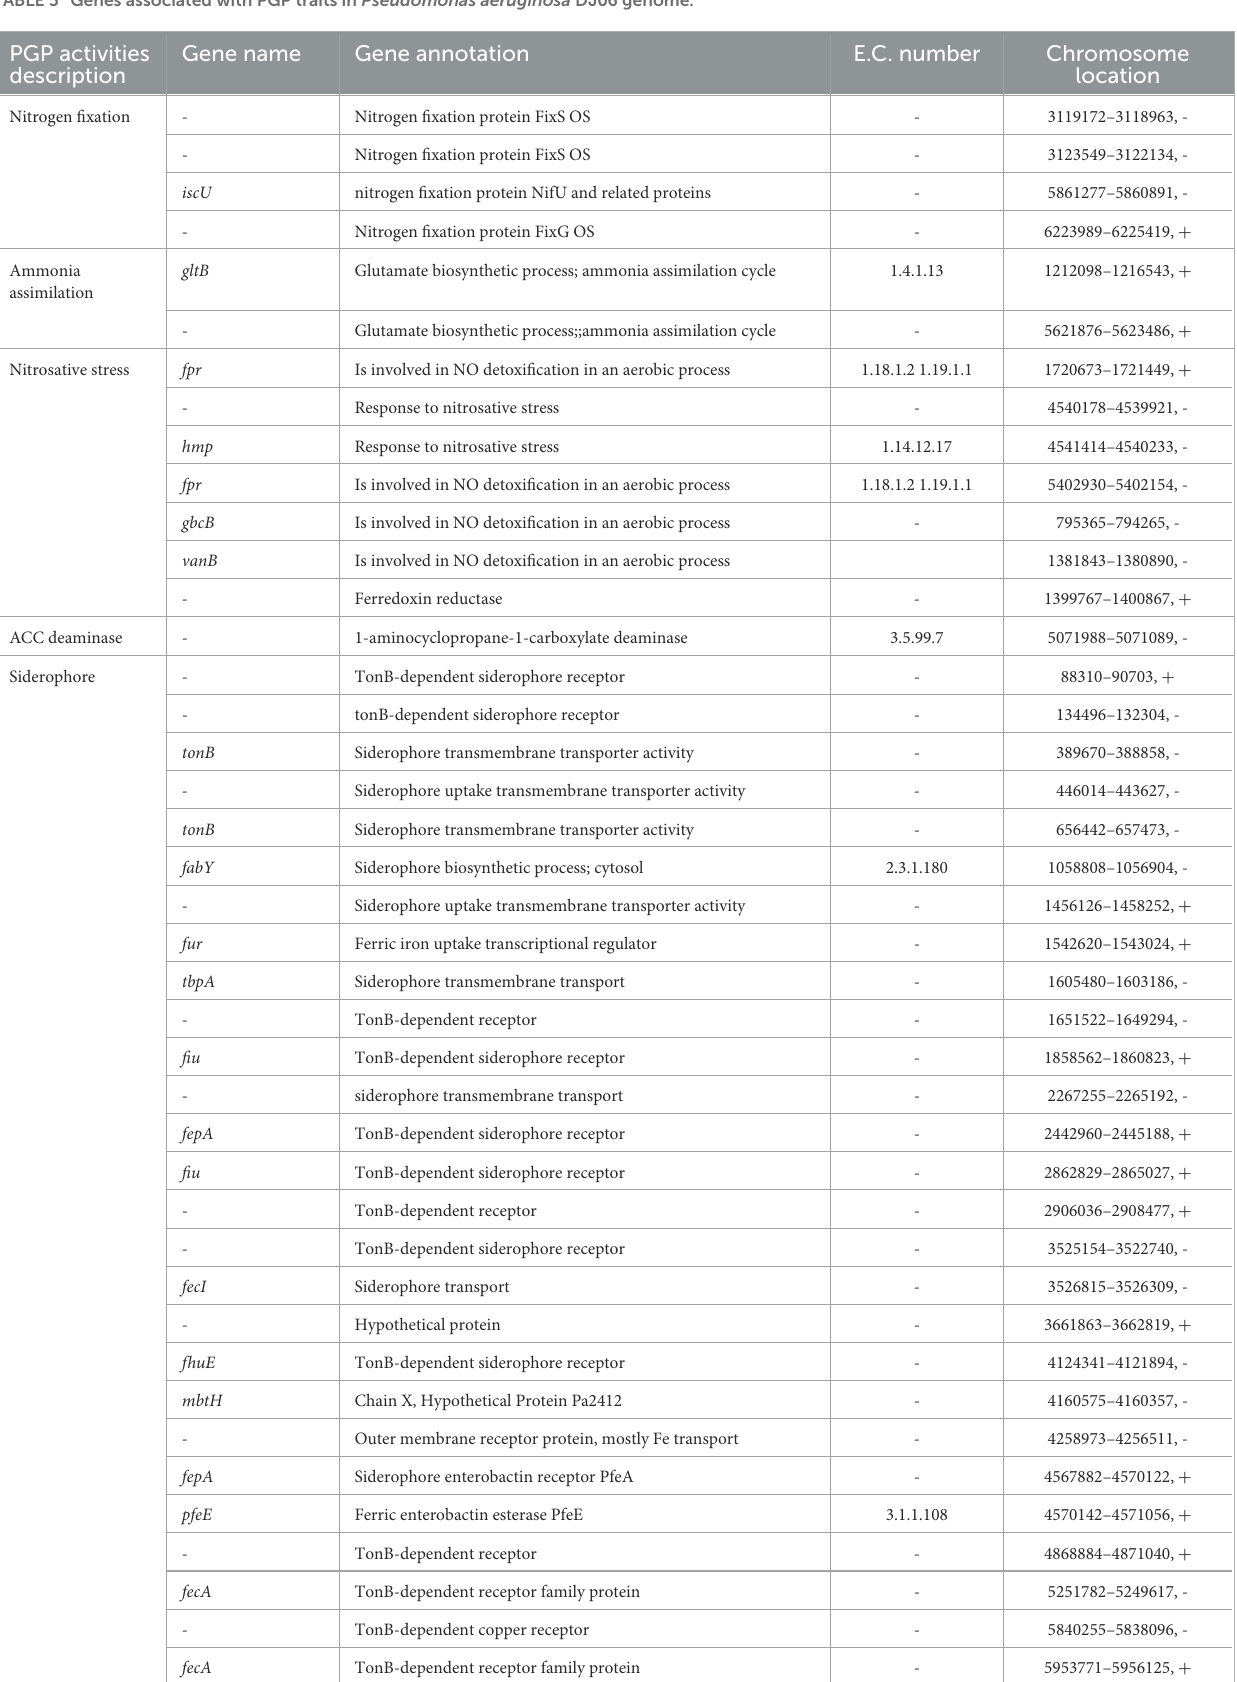
TABLE 5 Genes associated with PGP traits in Pseudomonas aeruginosa DJ06